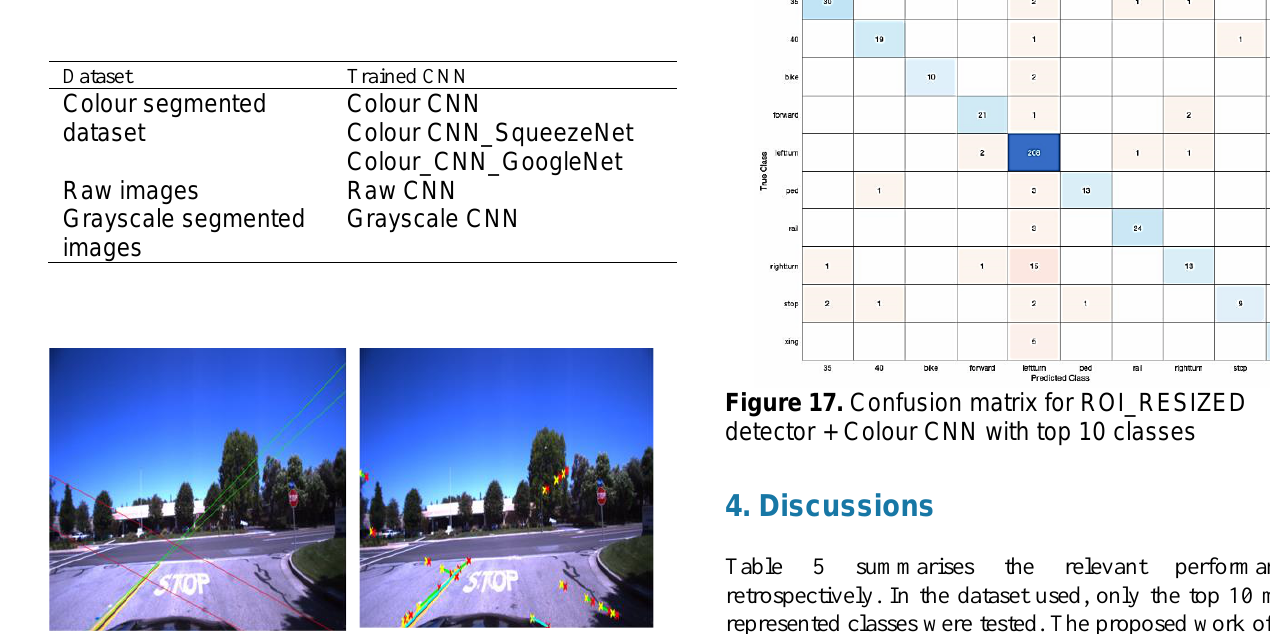
Figure 15. Hough lines on the image (left) and Hough line segments (right)